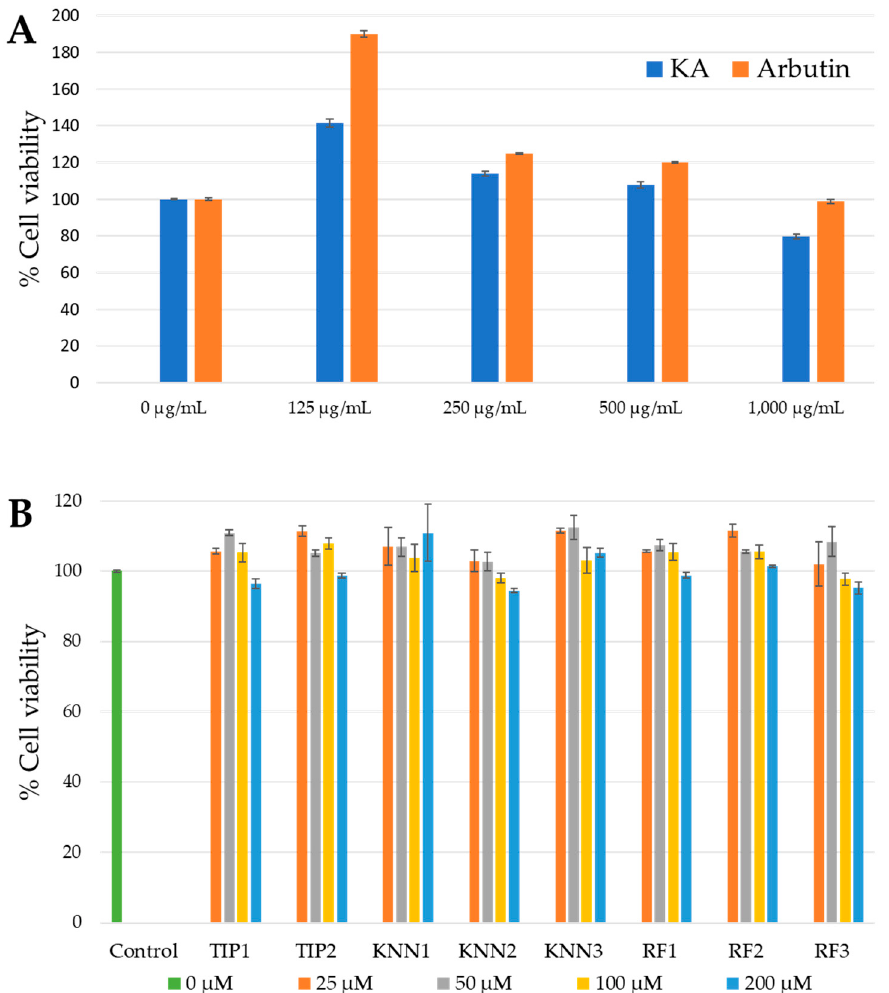
Figure 1. Effect of positive controls (kojic acid and arbutin) ( A ) and hdTIPs ( B ) on B16F10 melanoma cell viability, as assayed by MTT. The data were normalized by setting 100% equal to the viability of the untreated control group. Error bars indicate the standard deviation of mean among the three replications in each treatment